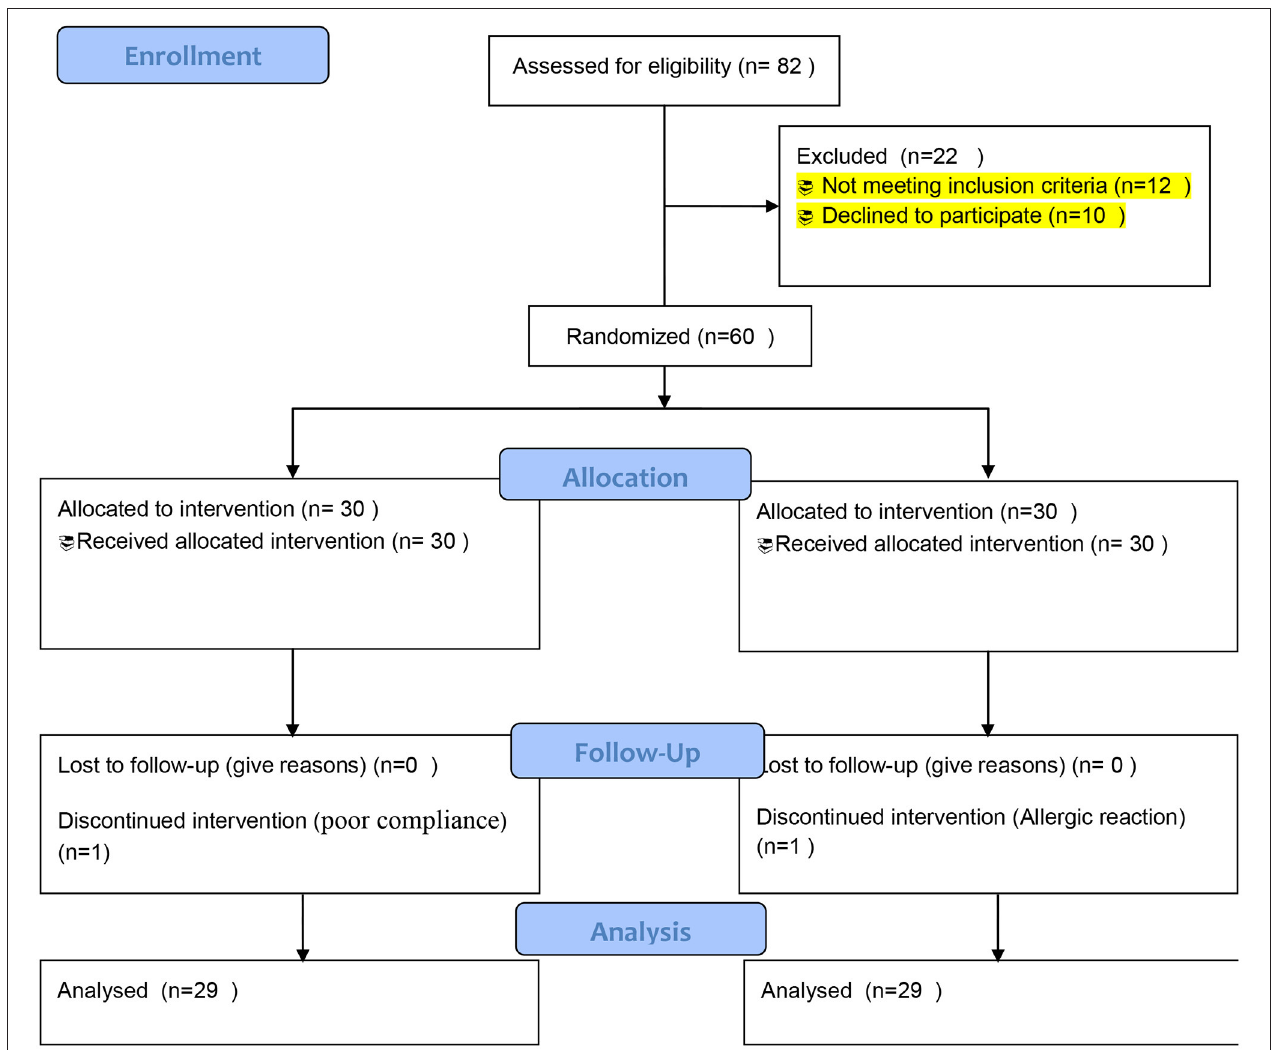
FIGURE 1 | Consolidated standards of reporting trials (CONSORT) flow diagram of the enrollment and follow-up of the